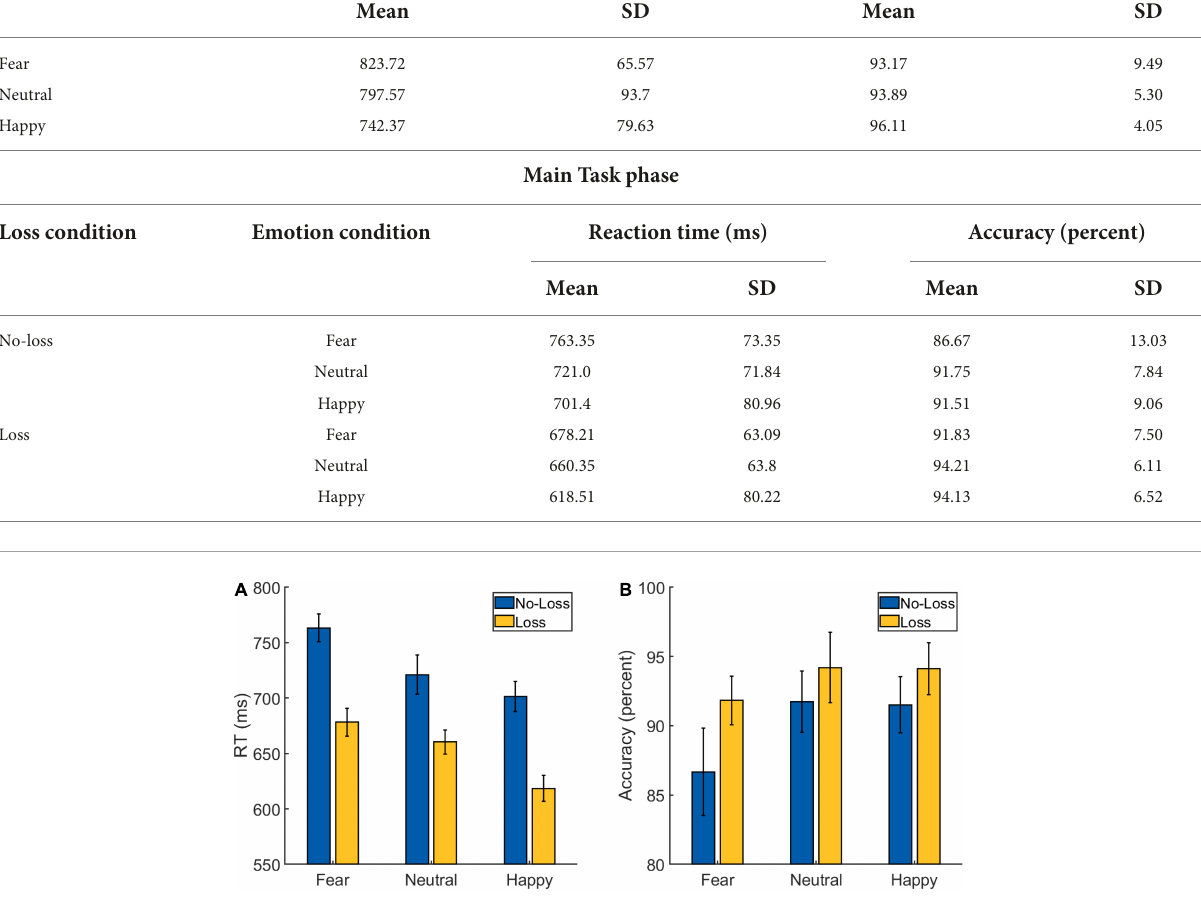
of appetitive and aversive motivation (representing